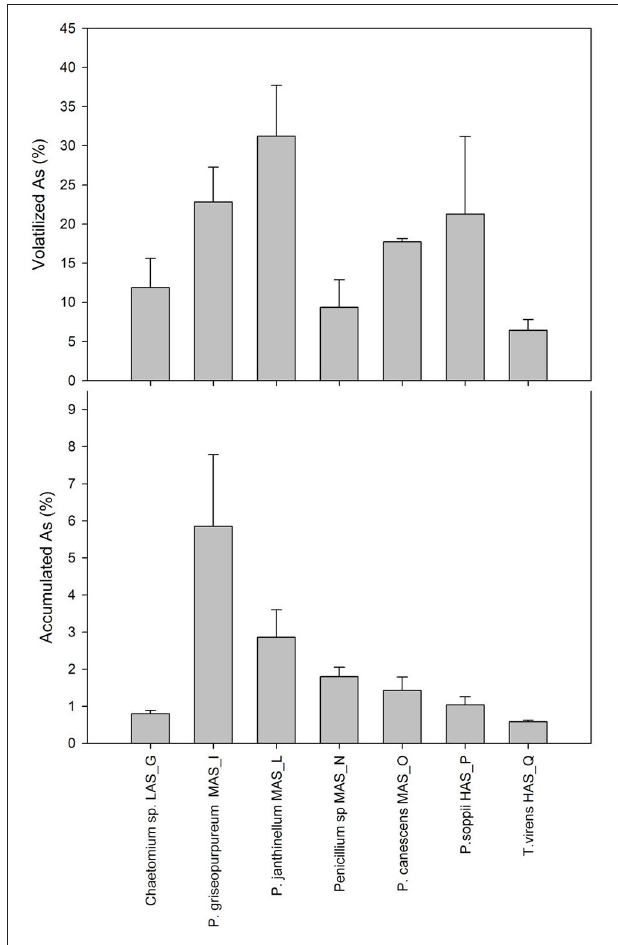
FIGURE 3 | Percentage of As volatilization (A) and accumulation (B) in 7-d-old shaken cultures of the fungal strains isolated from Pestarena soils and exposed to 10mg L − 1 As, supplied as sodium